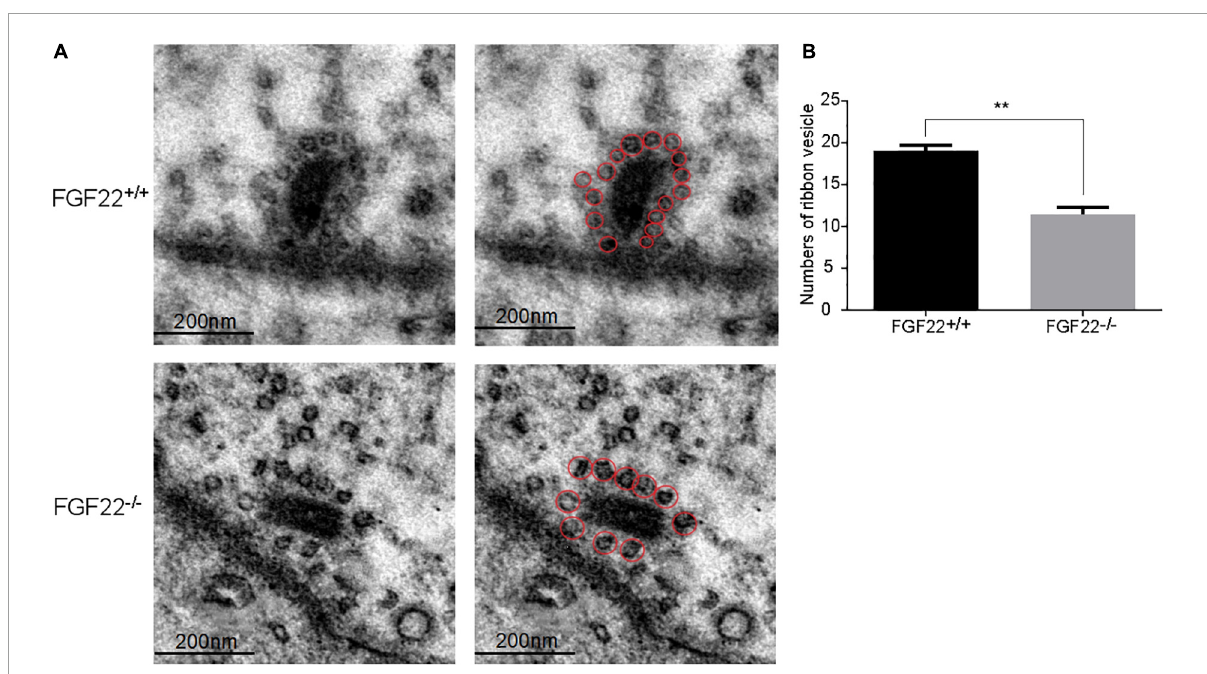
FIGURE4 The number of synaptic vesicles in the Fgf22 + / + and Fgf22 − / − groups. (A) Representative images of synaptic vesicles in the Fgf22 + / + and Fgf22 − / − groups under a transmission electron microscopy (TEM). Scale bars: 200 nm. (B) The number of ribbon SVs was significantly reduced in Fgf22 − / − mice than in Fgf22 + / + mice. ** P < 0.01 vs. the Fgf22 − / − group.